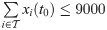
Initial tumor compositions for Forwards Backwards Sweep analysis.100 randomly selected initial tumor compositions used in the Forwards Backwards Sweep optimal control analysis. All initial total tumor volumes satisfy the patient viability constraint ∑i∈Txi(t0)≤9000.